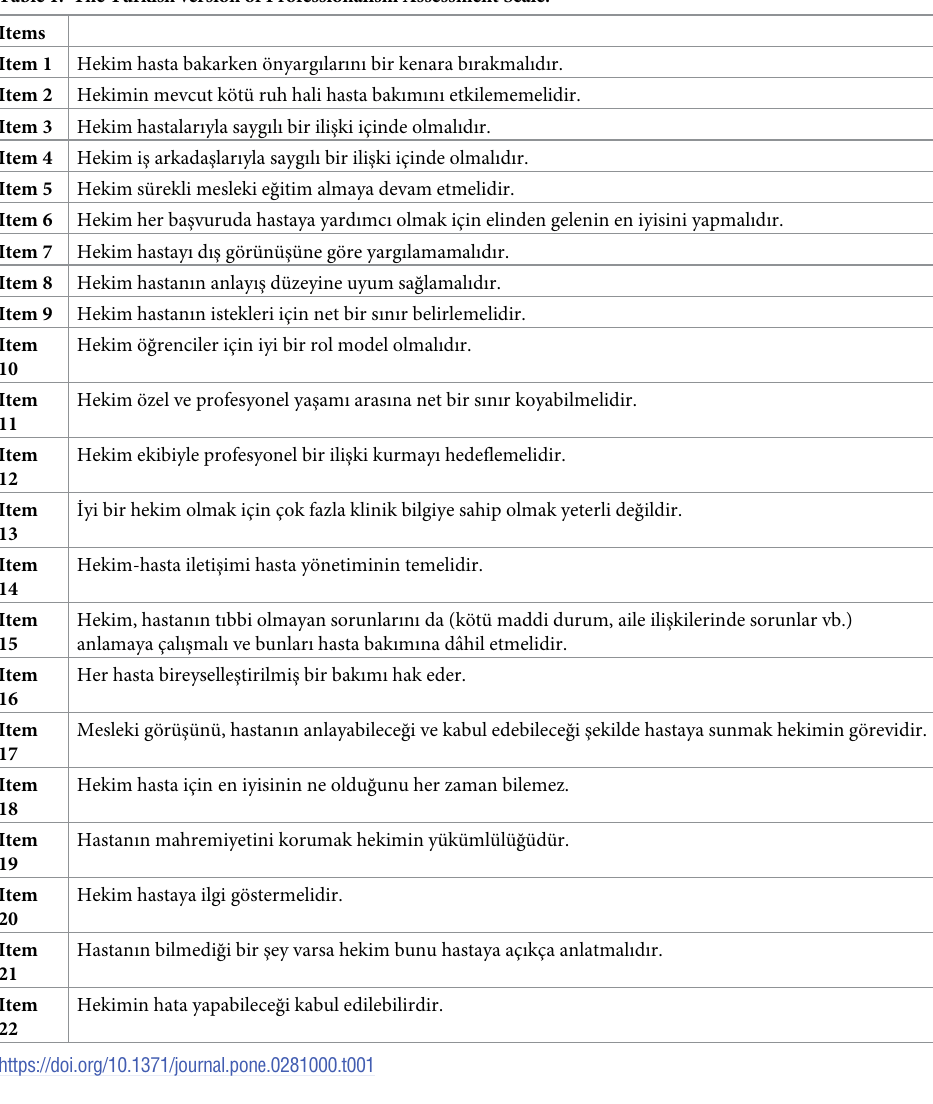
Table 1. The Turkish version of Professionalism Assessment